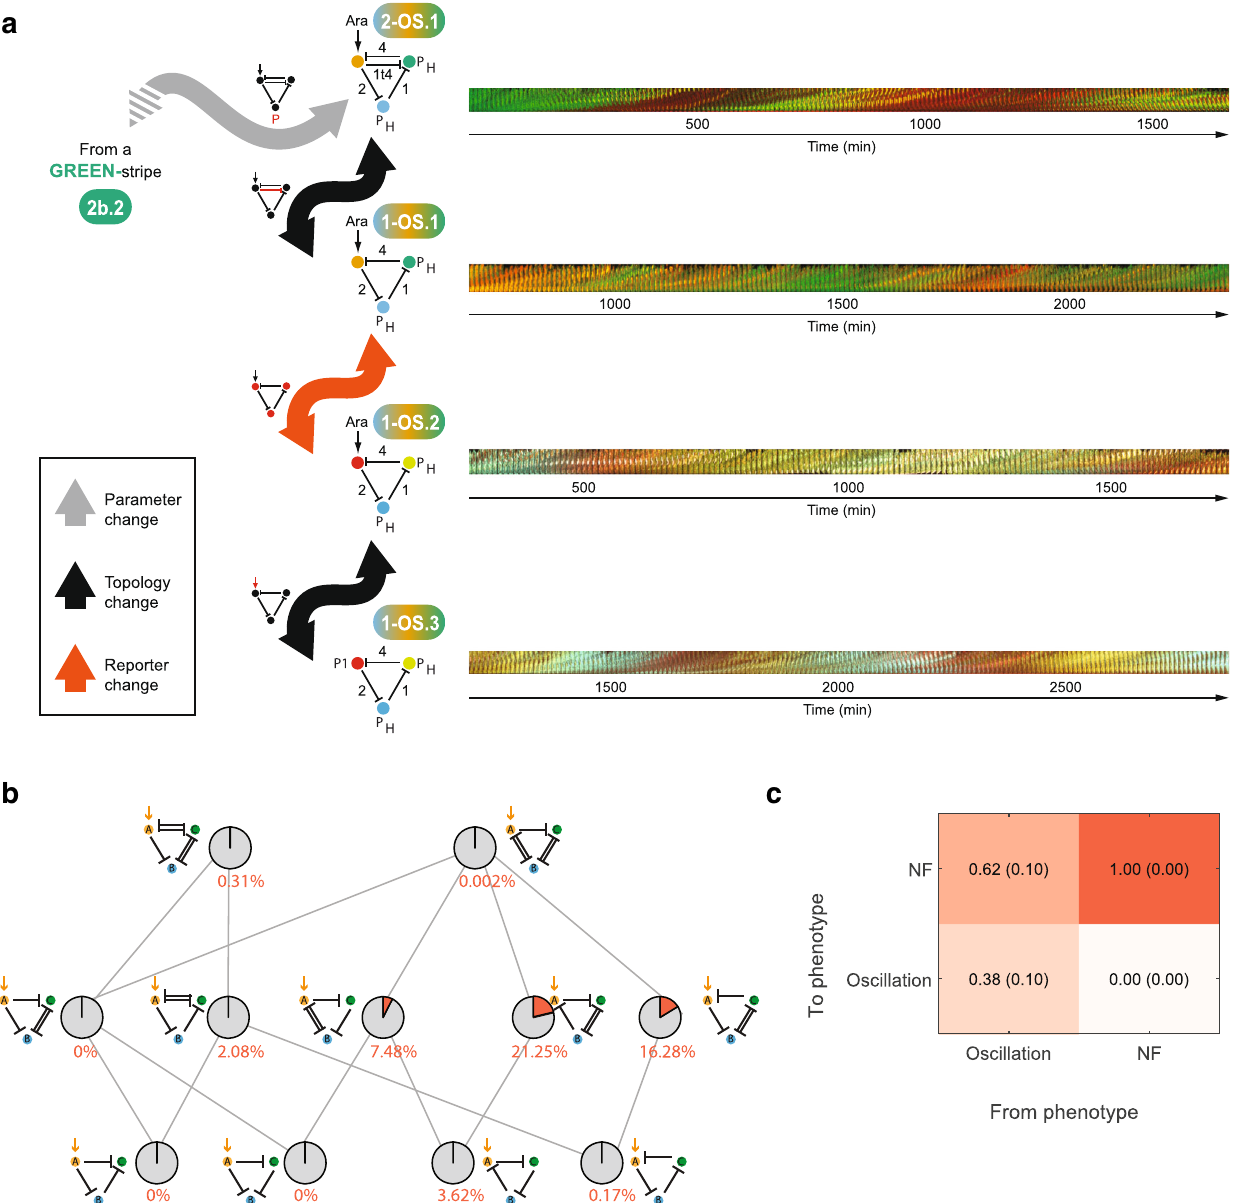
Fig. 7 | A synthetic genotype network of oscillatory GRNs. a Starting from the GREEN-stripeGRN 2b.2, a stronger promoter for the blue nodeleads to a GRN that displays oscillatory expression. Few changes suf fi ce to transition to the CRISPRlator 51 , with all intermediates showing the oscillatory phenotype. Bacteria carrying the indicated GRNs were grown in continuous exponential phase in a micro fl uidic device and imaged every 10min for up to two days. Oscillations are shownaskymographs: imagesof the micro fl uidicchamber (hosting ~100cells) are displayedinorderinatimelinemontage.DuetoanoverlapofmKO2andmKate2in the same channel, red color for 2-OS.1 and 1-OS.1 (top) represents both mKO2 and